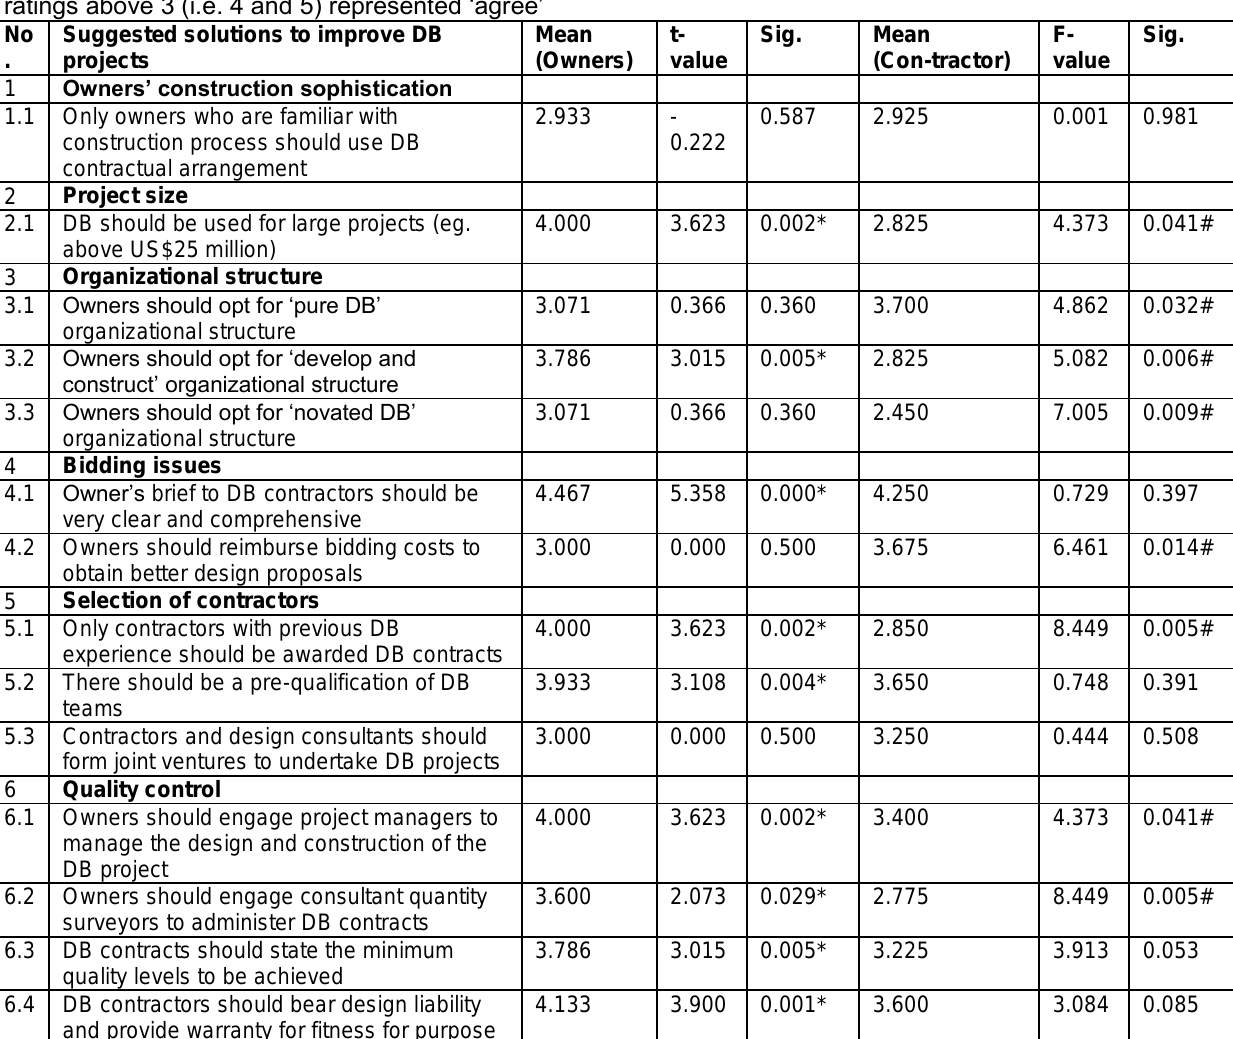
Table 1 : Survey results on solutions to make DB projects more